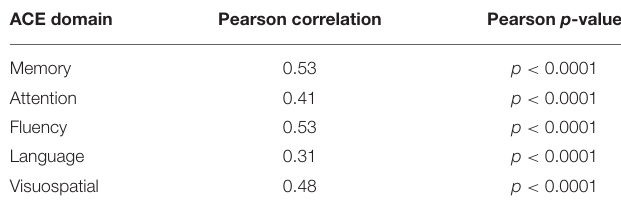
TABLE 3 | Correlation of the ICA with cognitive domains of ACE.